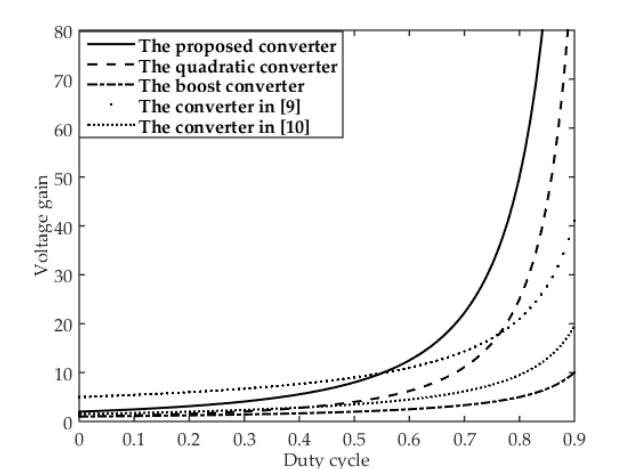
Figure 4. Voltage gain comparison of converters.